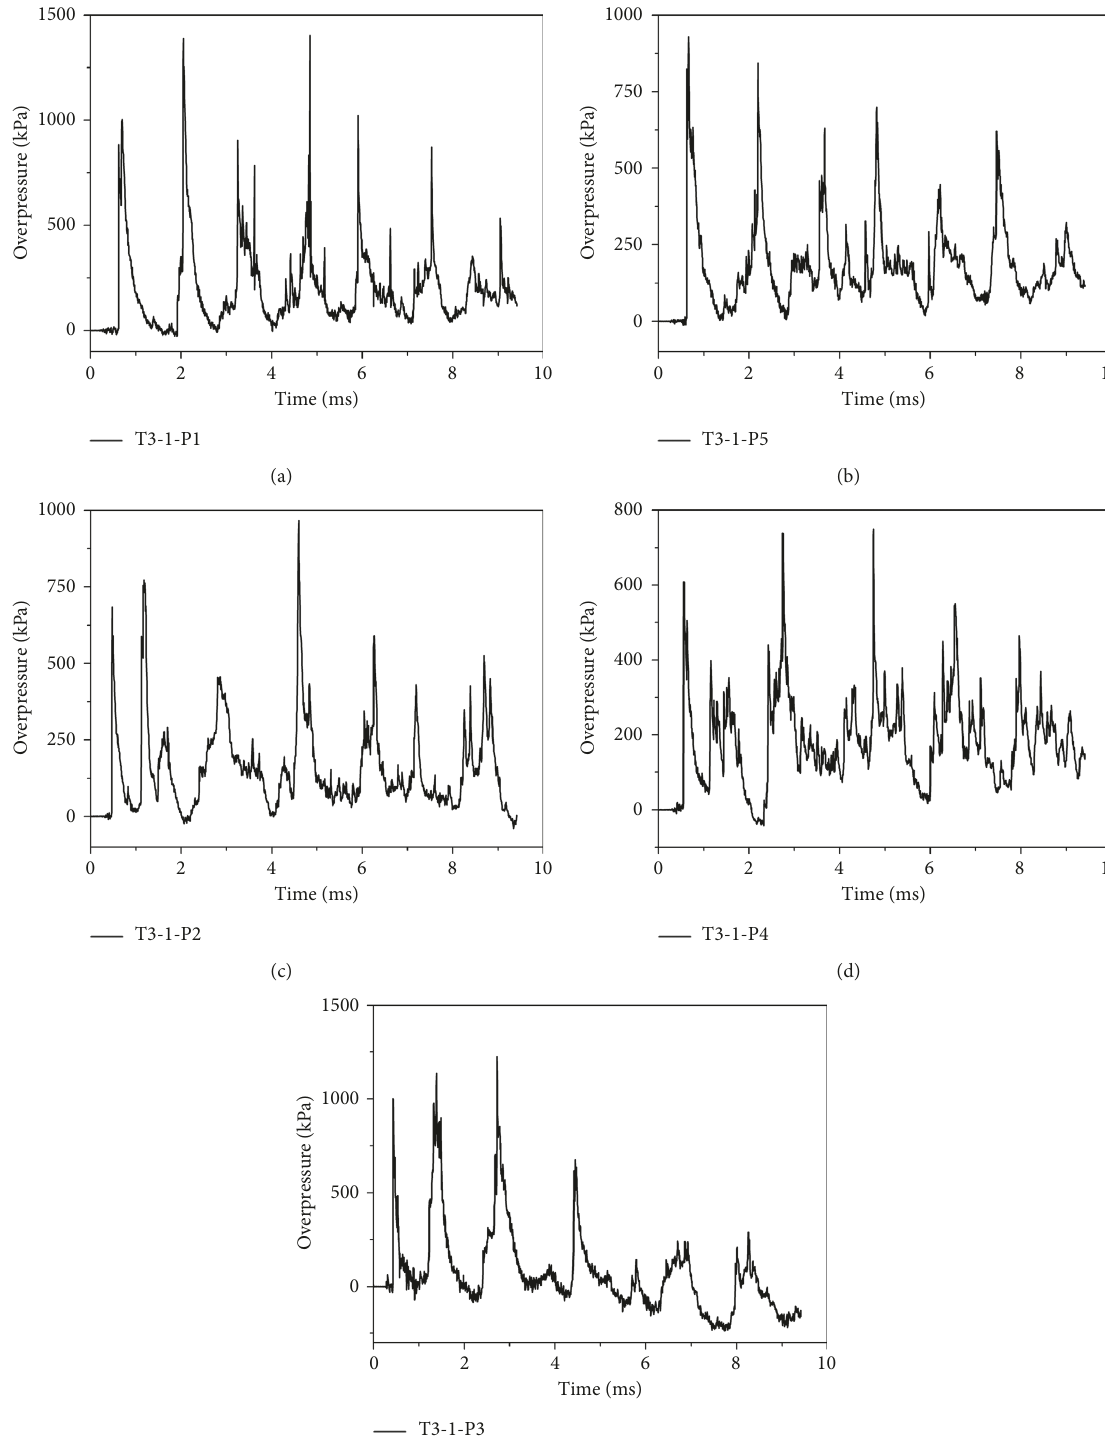
Figure 9: Experiment data from scenario T3 (15g TNT). (a) Test data from P1. (b) Test data from P5. (c) Test data from P2. (d) Test data from P4. (e) Test data from